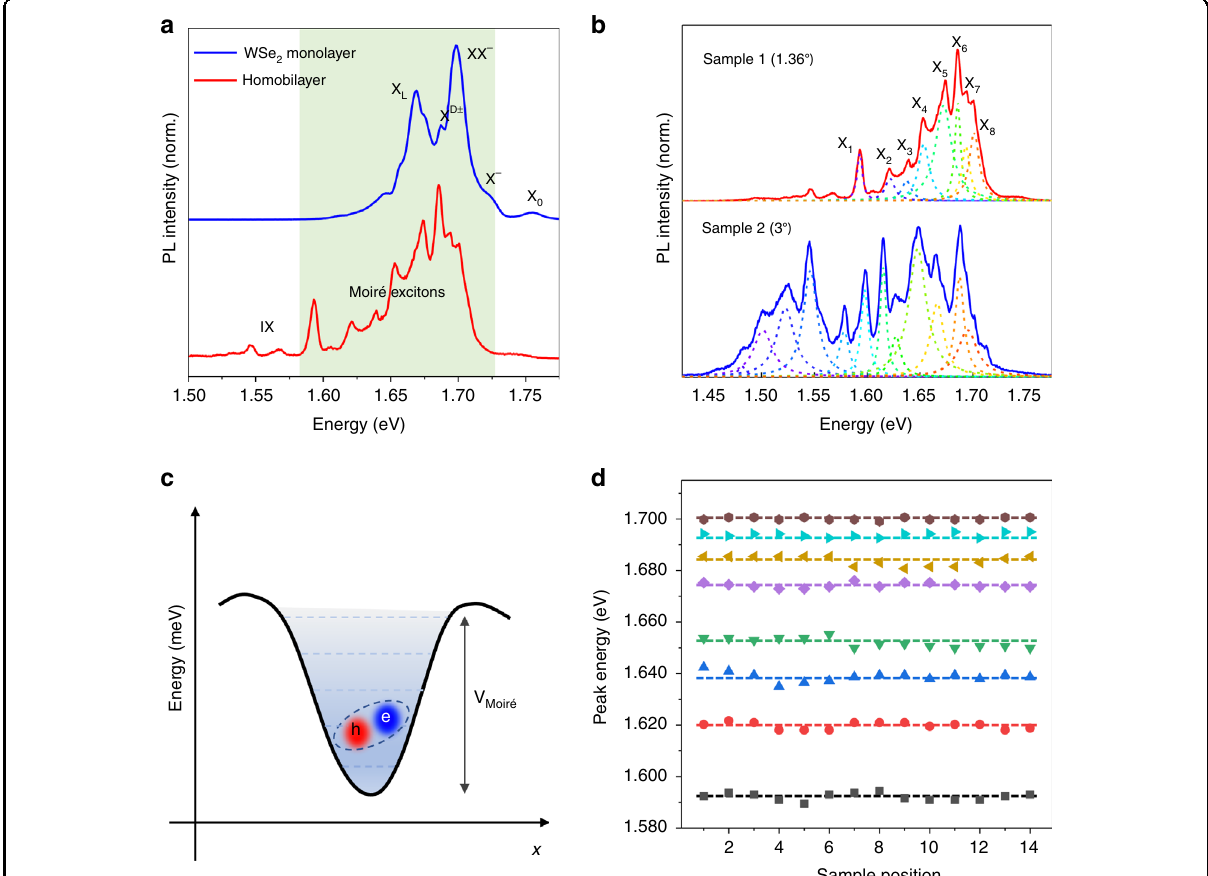
Fig. 3 Optical characteristics of moiré intralayer excitons in WSe 2 /WSe 2 twisted homobilayer. a Comparing the PL spectra of WSe 2 monolayer and homobilayer region at 8 K, there are many small split peaks in the twisted bilayer, the energy position of which is different from that of the monolayer, and interlayer excitons appear in the low energy region. b PL spectra of homobilayers with twist angles of 1.36° and 3°. Many split small peaks are fi tted by Lorentzian function, and the dotted lines of different colors represent different peaks. c Illustration of the spatial variation of the moiré potential (V Moiré ) and the trapped intralayer excitons. d The central energy values of the splitting small peaks were extracted from the PL spectra at different positions of the homobilayer with a twist of